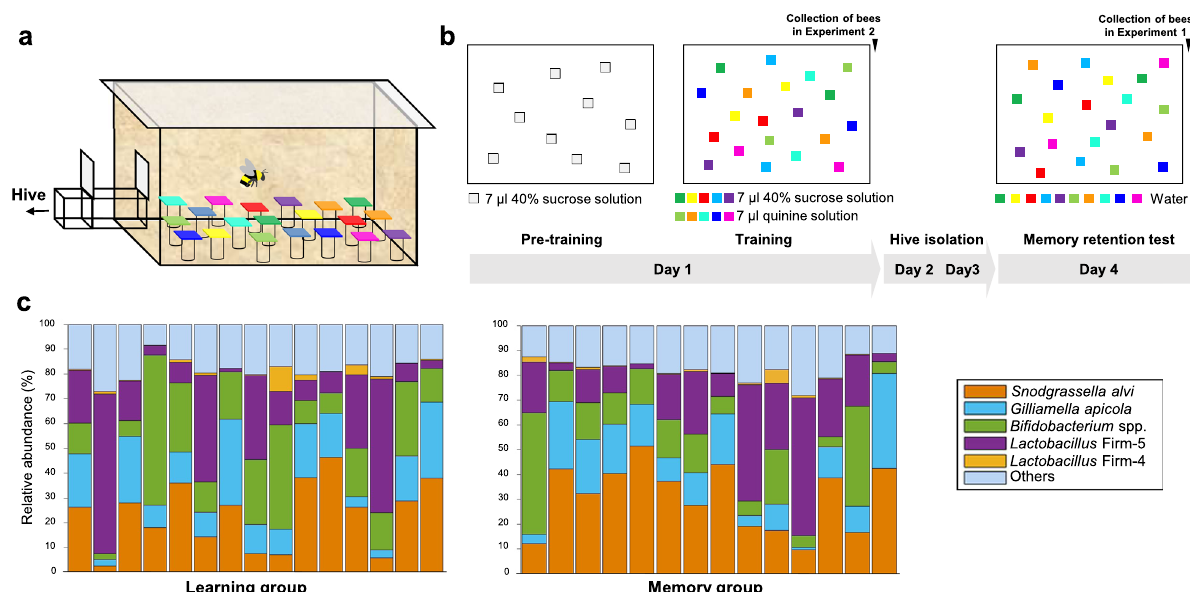
Fig. 1 Behavioural paradigm and gut microbiome composition of individual bees. a Foraging arena setup with arti fi cial fl owers used for 10-Colour Learning. b Training procedures. Grey squares: transparent chips. Coloured squares: coloured chips (Supplementary Fig. 1a and the authors ’ published work 9 ). c The relative abundance of gut bacterial phylotypes in individual bees from the Learning group ( n = 15) and Memory group ( n = 14). Each column represents an individual bee. Source data are provided as a Source Data fi